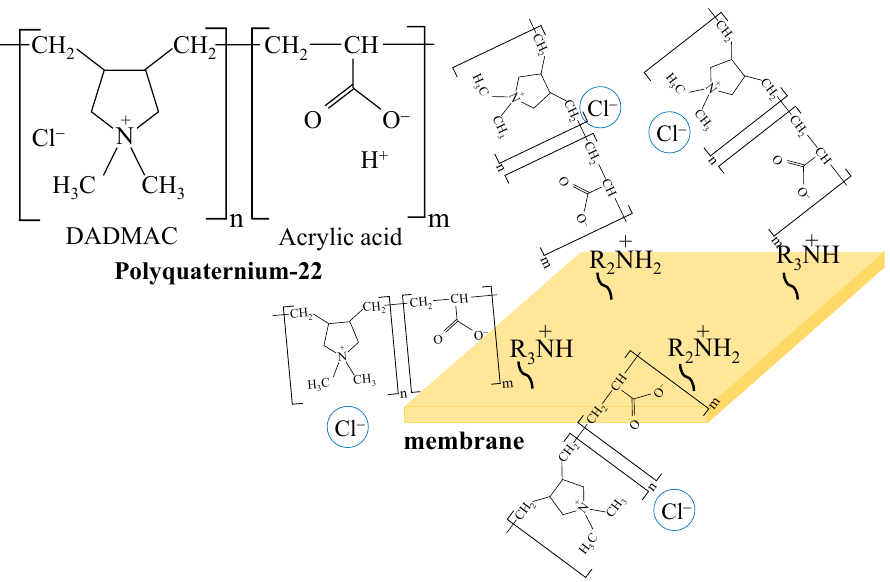
Figure 1. Interaction of modifier with functional groups on the surface of MA-41P membrane. The electrochemical characteristics of the studied membranes were measured in 0.02 M sodium chloride solution. This binary electrolyte is most often used for testing ion-exchange membranes if there is no connection to a specific process. This concentration was selected since, at this concentration, the co-ion transfer through the membrane is negligible for most membranes; however, current-induced phenomena (water dissociation and electroconvec- tion, which occur in real electrodialysis) are well developed. 2.3. Flow-Through Electrodialysis Cell for Measuring Electrochemical Characteristics A flow-through four-chamber electrodialysis cell with setup (Figure 2) and an Au- tolab PGSTAT 302N potentiostat-galvanostat with a FRA32M impedance measurement module were used to record current-voltage characteristics, CVC, and impedance spec- tra. For ease of comparison of the results, the experiments were carried out at current densities normalized to the values of the theoretical current density, i lim , obtained by the L é v ê que equation within the framework of the convective-diffusion model (please see Supplementary Materials). The calculated value of i lim is equal 3.0 mA/cm 2 . An electrolyte solution (0.02 M NaCl, pH 5.6 ± 0.1) from two containers (1) entered a four-chamber electrodialysis flow cell. The investigated anion-exchange membrane (AEM) (2) (working area is 4 cm 2 ) and auxiliary cation-exchange membranes (CEM) (3) (MK-40, Shchekinoazot), using frames (4), formed a concentration chamber (CC), a desalination chamber (DC), and electrode chambers (EC 1 and EC 2 ) of the electrodialysis cell, in which the flow rate of the solution was set using taps (5) and amounted to 27 mL/min ( ≈ 0.4 cm/s). At the outlet of the CC and DC, the composition of the solution was continuously monitored using combined pH electrodes (6) and conductivity sensors (7) connected to Expert-001 pH meters and Expert-002 conductometers (Expert-Econix, Russia) (8), respectively. Then, the solutions entered two tanks (9), in which the solutions from DC and CC and from EC 1 and EC 2 , respectively, were mixed. The spent solution from the tanks (9) was supplied using pumps in the containers (1), realizing a circulation-type hydraulic system. The solution (V = 15 L) was changed approximately every 10 h of